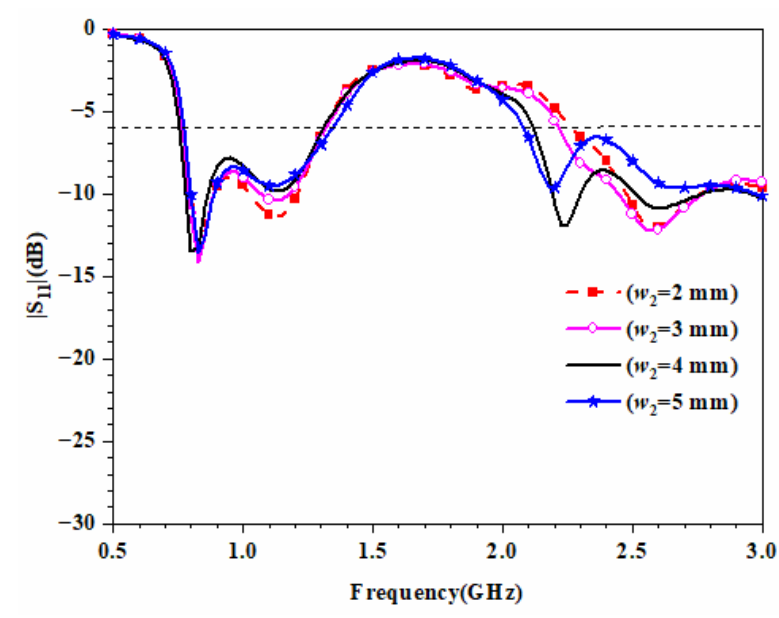
Figure 4. Influence of w 2 on |S 11 |.